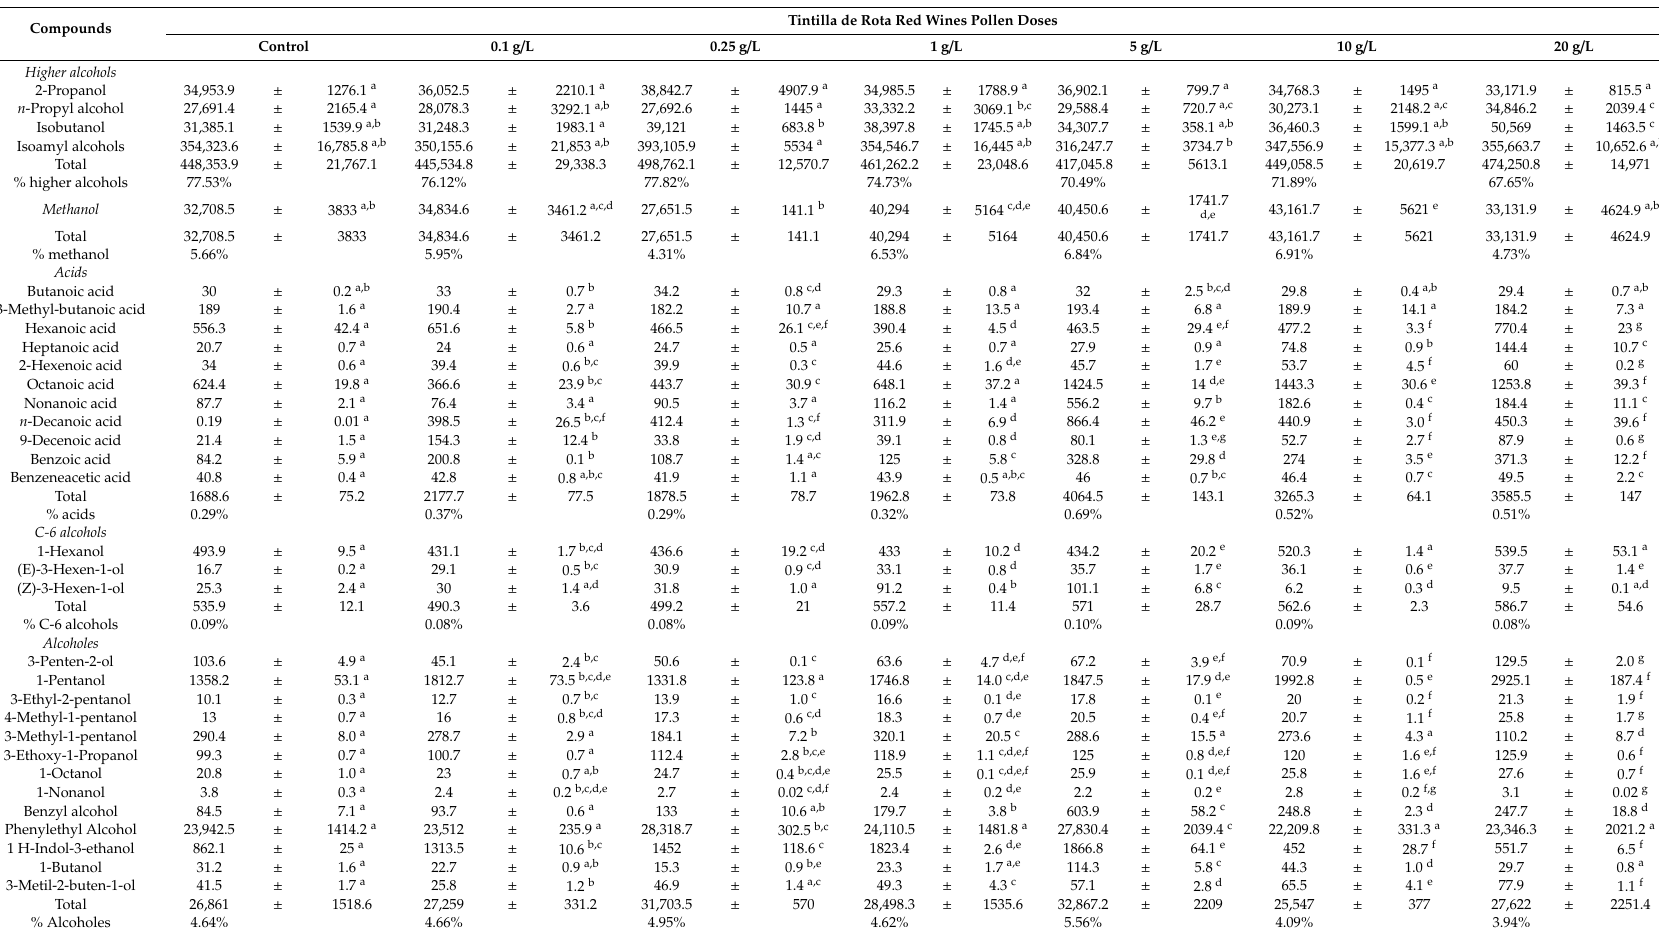
Table 1. Comparative e ff ect of the addition of bee pollen (0.1, 0.25, 1, 5, 10 and 20 g / L) on concentrations of volatile compounds ( µ g / L) and control elaboration of Tintilla de Rota red